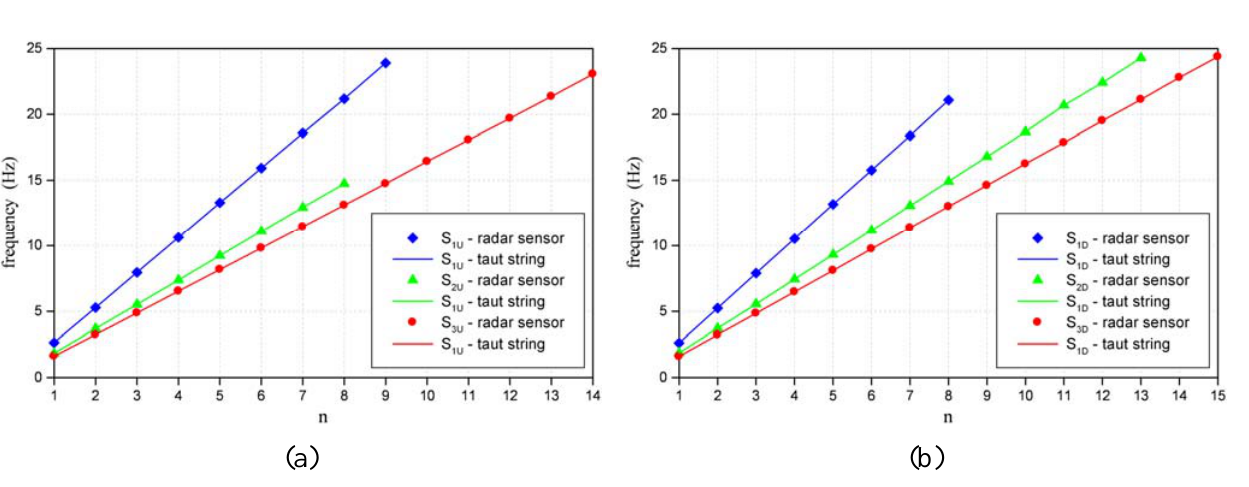
Figure 11. Experimental and taut-string based natural frequencies of: (a) upstream-side forestays and (b) downstream-side forestays.